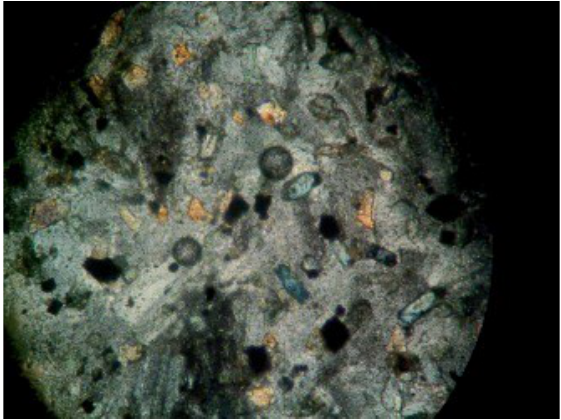
Fig. 10. Petrographic image of thin section. Possible ball- like biomicrobodies (?) in the meteor Pallasite from Tsenkher astropipe crater. Thin section 11/06. Japanese microscope Nikon ECLIPSE E400 POL (Dorjnamjaa et al.,